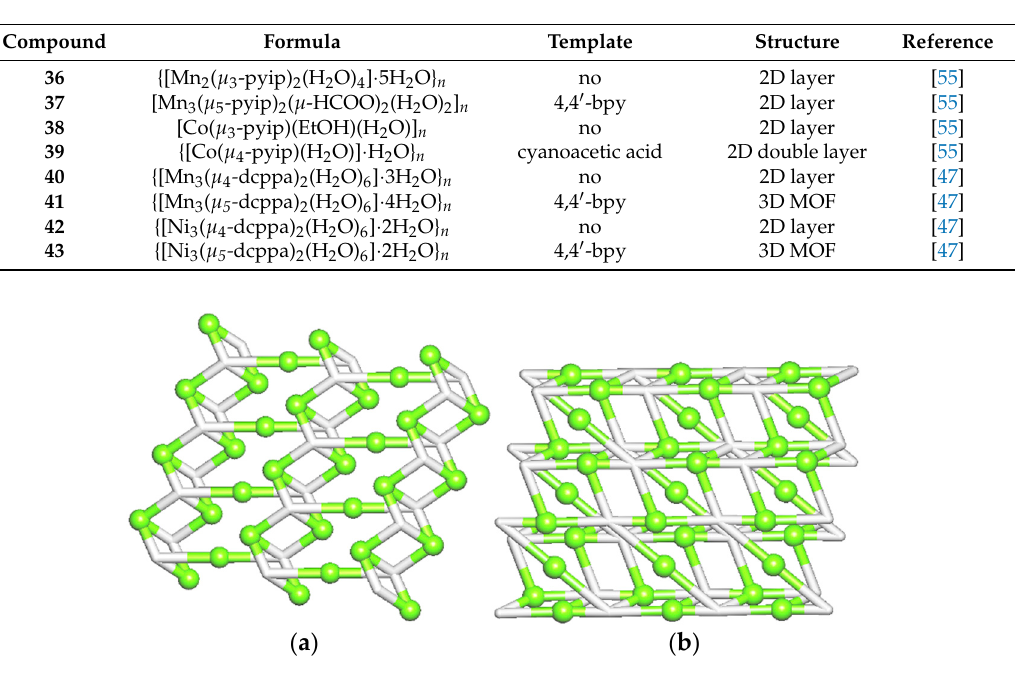
Table 6. Selected examples of CPs showing an effect of template on product structure.